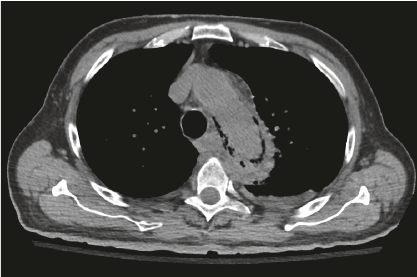
Figure 2: CT chest (sagittal view) showing emphysematous aortitis.